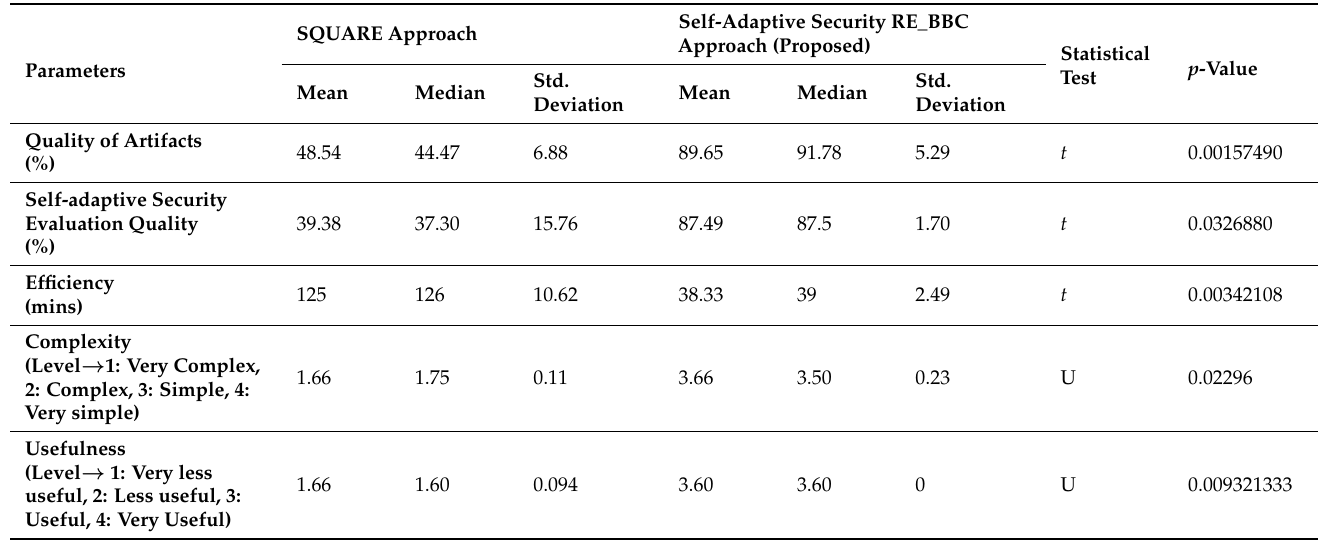
Table 4. Statistical test results on the feasibility study for healthcare data management system.